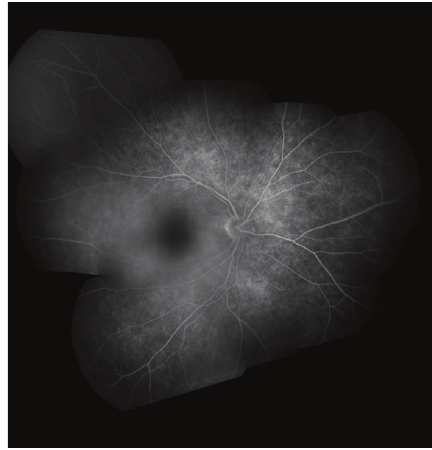
Figure 3: Fundus fluorescein angiogram of right eye (montage picture) showing normal retinal and choroidal